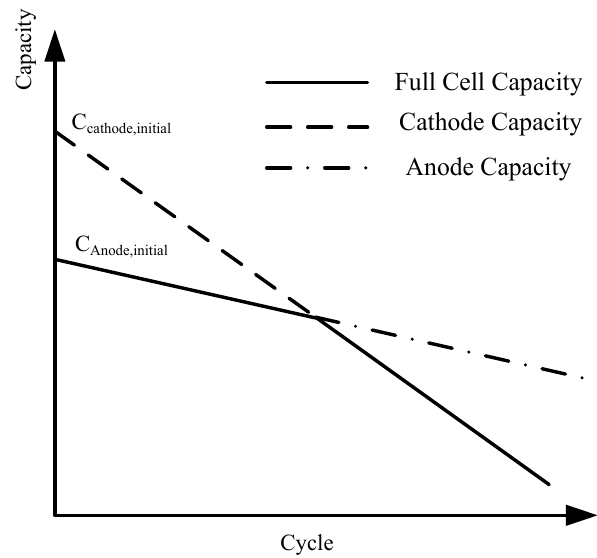
Figure 7. Schematics of the two-stage capacity fade